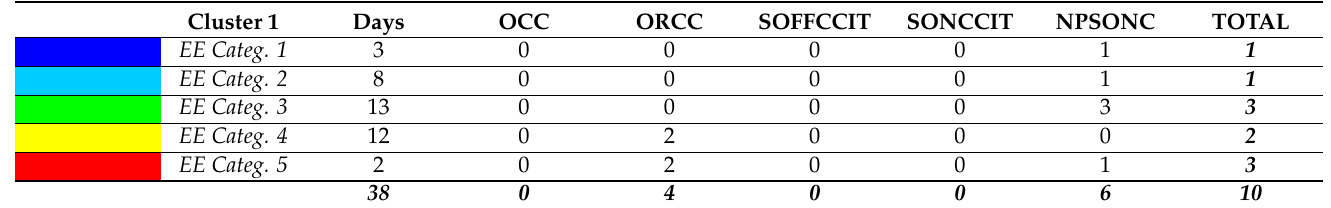
Table 4. Cluster 2 anomaly distribution. Each EE Category is associated with a color as depicted in Figure 12.